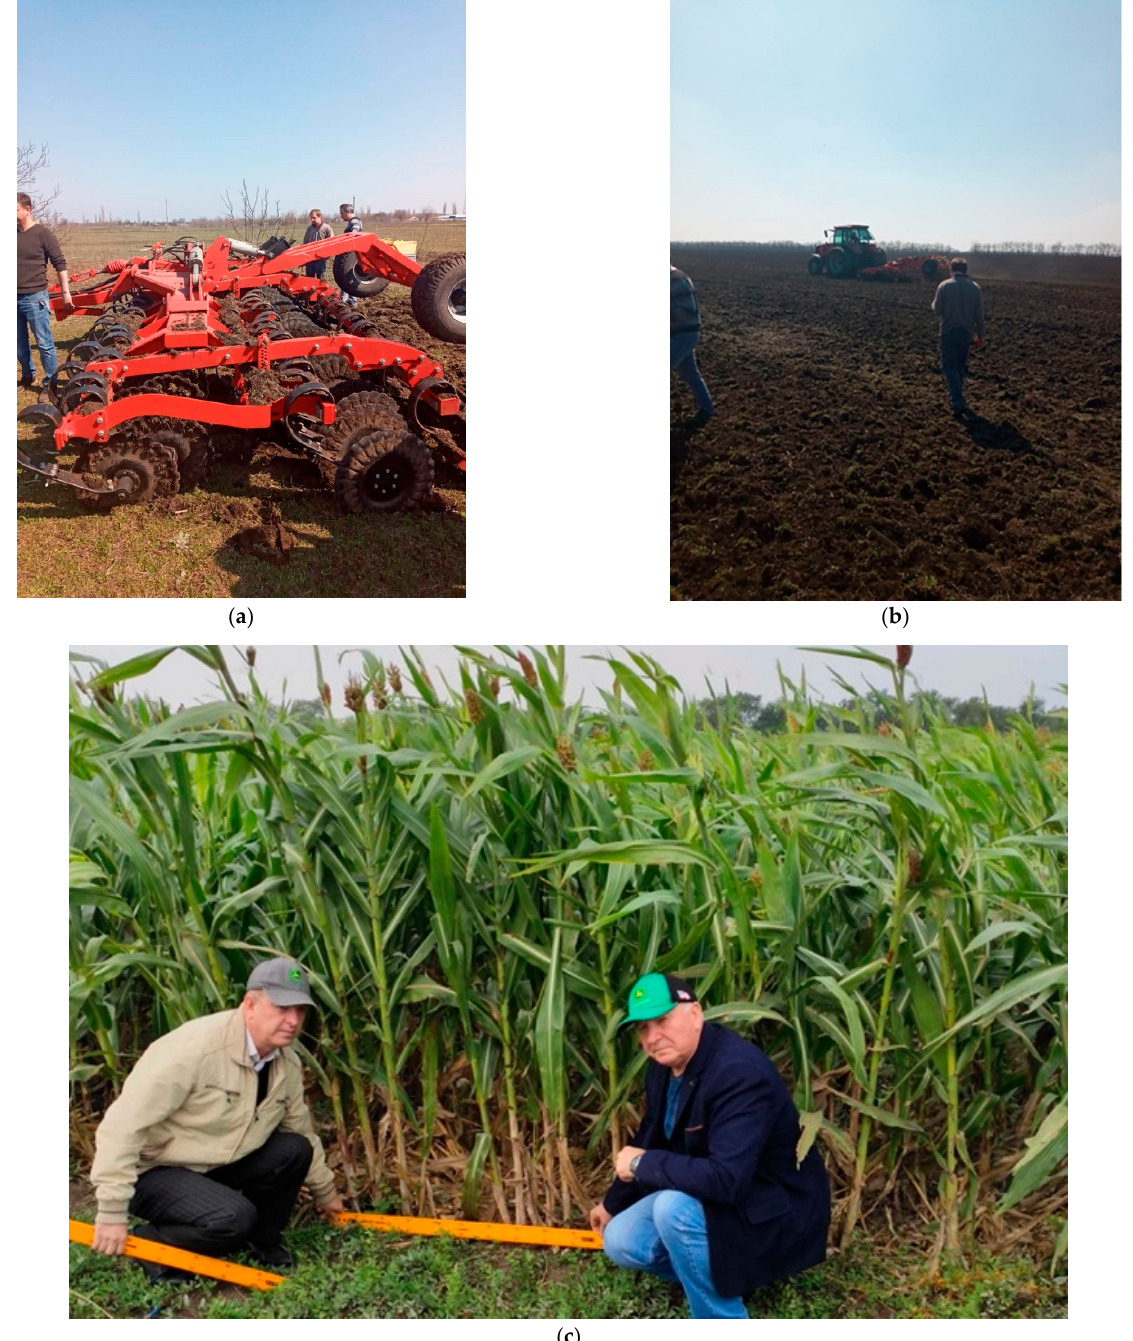
Figure 2. Sweet sorghum production: ( a ) a disc harrow; ( b ) shallow tillage; and ( c ) field studies.